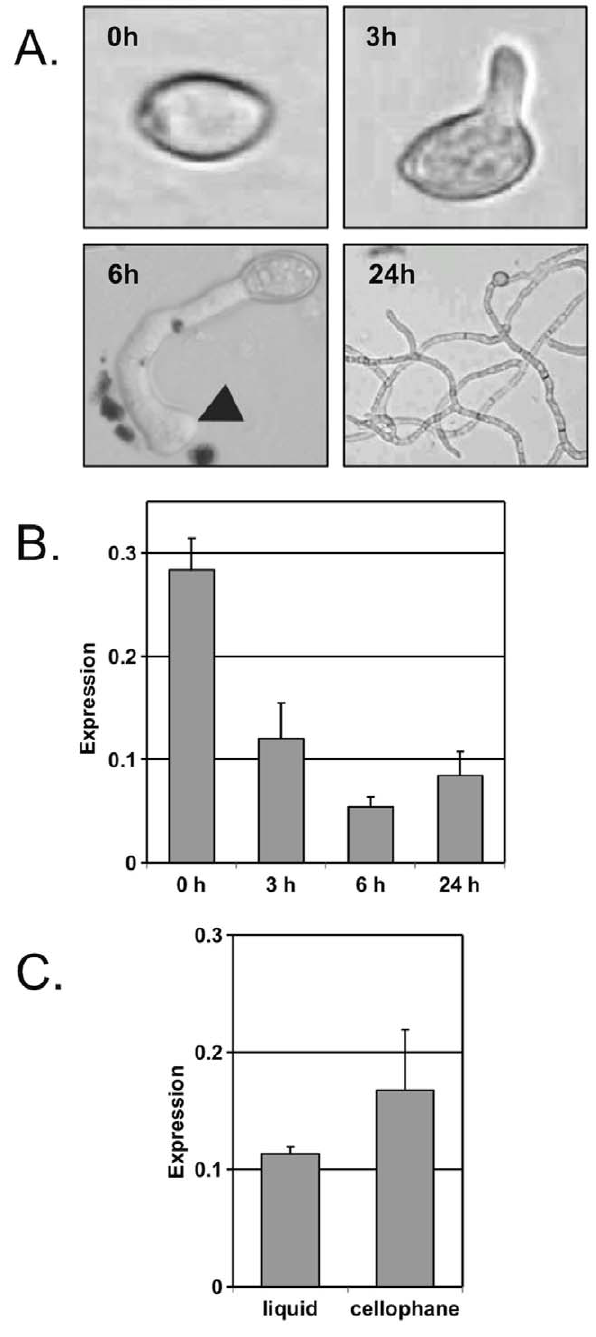
Figure 6. Expression of the BcHOX8 gene in the B05-10/ D ku70 parental strain. (A) Kinetic of B. cinerea development on Teflon membrane using conidia as starting material; germinated conidia, appressoria (triangle) and young mycelium are shown. (B) BcHOX8 expression on Teflon. RNA were collected at the four stages shown in A and used for quantitative RT-PCR analysis (3 biological repeats). (C) BcHOX8 expression in infection cushions-enriched samples. RNA were extracted from mycelium grown in liquid cultures or onto floating cellophane (enriched in infection cushions) and used for quantitative RT-PCR analysis (4 biological repeats). Standard deviations are indicated and the actin-encoding gene was used as reference. When the EF1 a - encoding gene was used as reference, identical results were obtained in B and a 2-fold higher differential was observed in C.